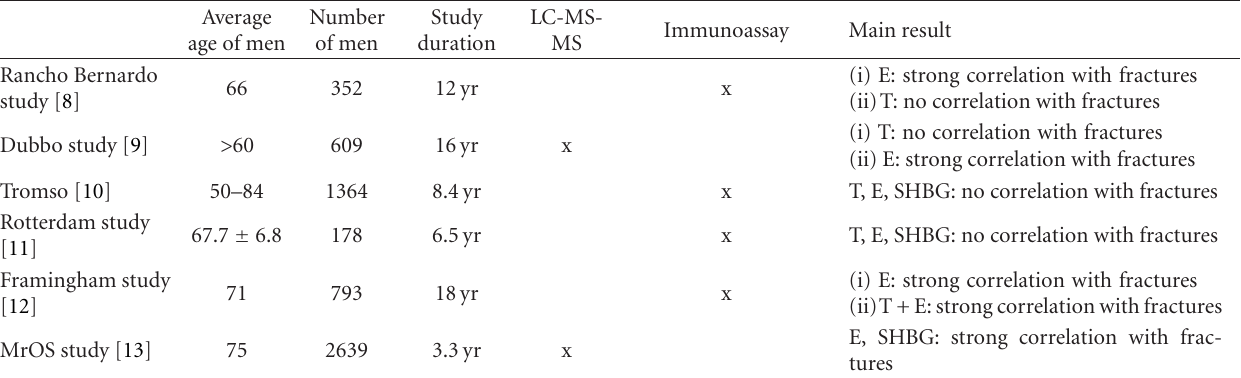
Table 2: Overview of cohort studies in